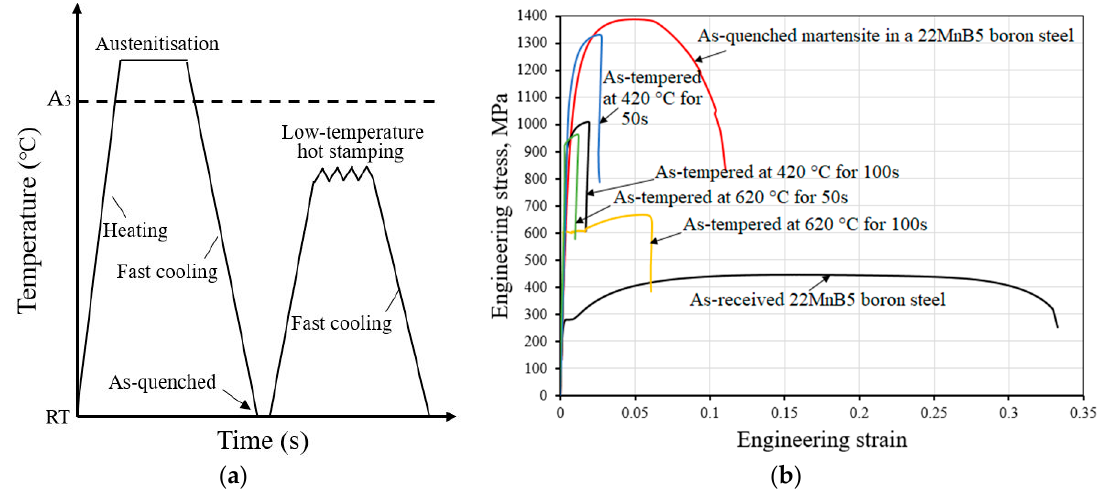
Figure 7. A novel process of low-temperature hot stamping of as-quenched 22MnB5 steel: ( a ) Schematic representation of the process; ( b ) room-temperature properties after indicated heat-treatment conditions [79].